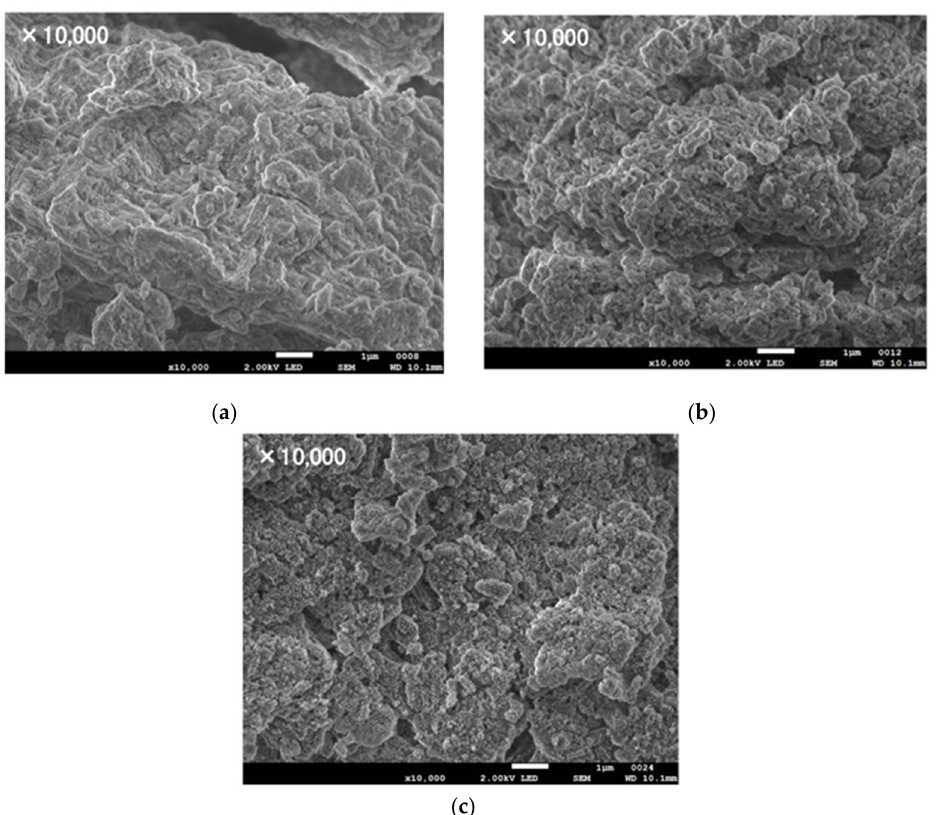
Figure 11. SEM images: ( a ) Particle size of LiOH 32–45 um before the reaction; ( b ) LiOH after the reaction of hydration 47 °C , 3 kPa and dehydration (80 °C vacuum for 24 hours); and ( c ) LiOH after the reaction of hydration at 47 °C, 5 kPa and dehydration (80 °C vacuum for 24 hours).